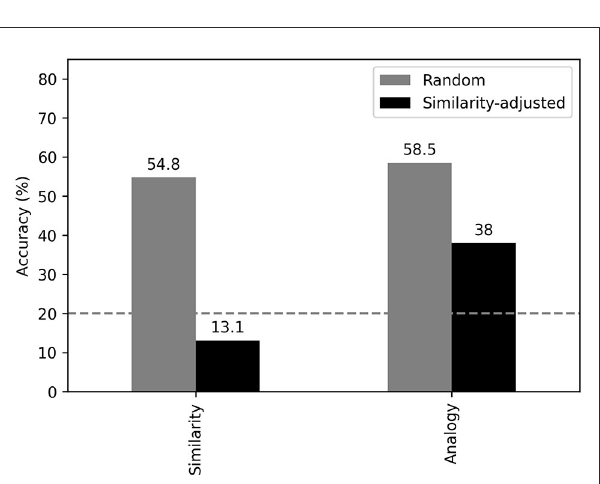
FIGURE4 Predictive accuracy of the analogy model and the similarity model in inferring target meanings of semantic change. Models are evaluated based on randomly chosen and similarity-adjusted target candidates. The dashed line indicates chance accuracy